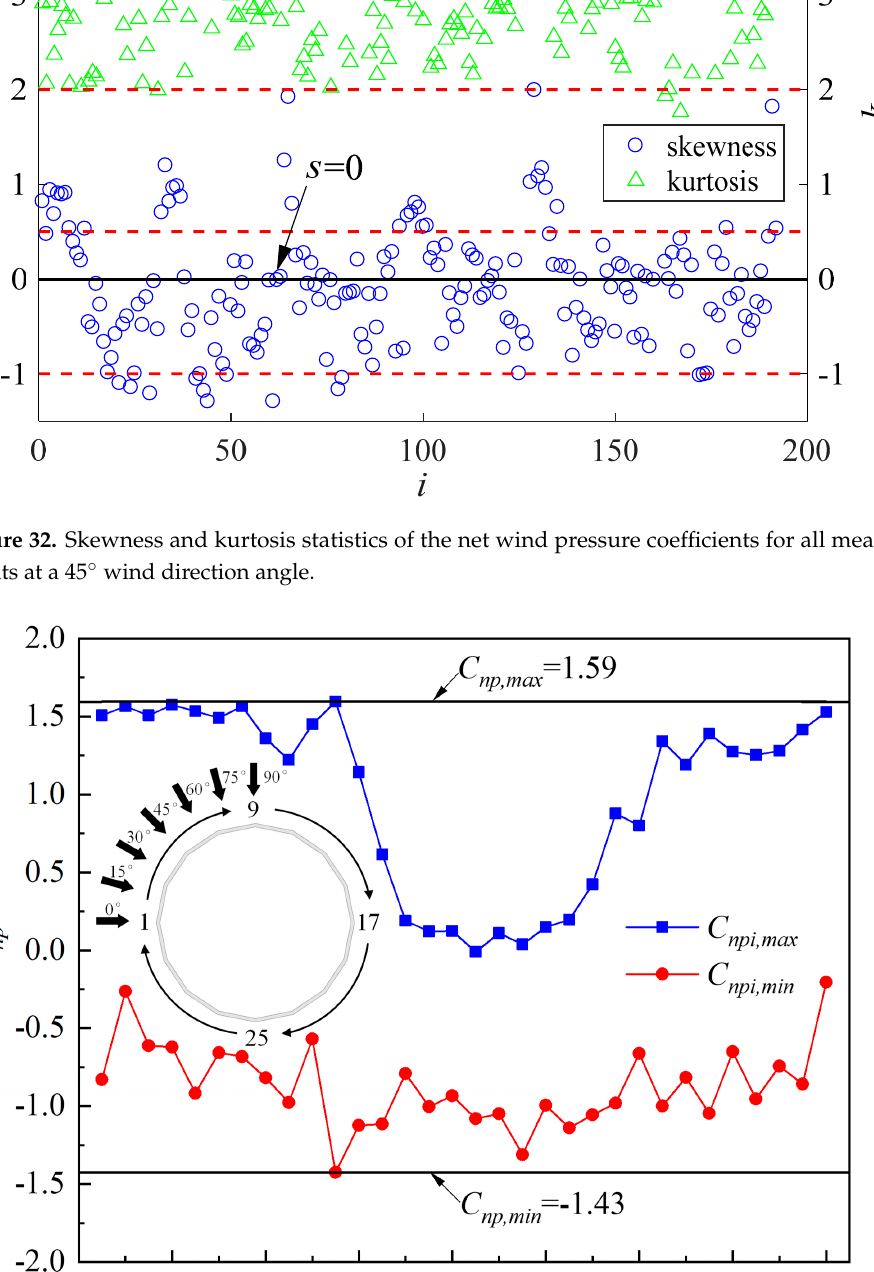
m is the number of outermost grids; i P is the mean static wind pressure over the time history of the grid i ; i A is the surface area of the building corresponding to grid i ; i z is the height corresponding to grid i ; i α is the angle between the X -axis and the external normal direction of the building surface corresponding to the grid i.